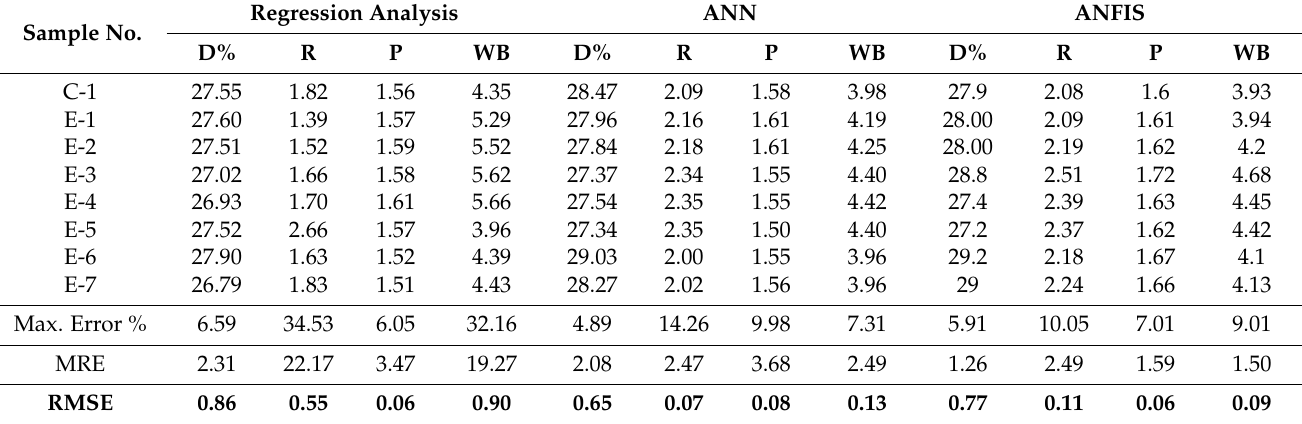
Table 10. Tabulation of results obtained from developed prediction models outside input design range. Sample